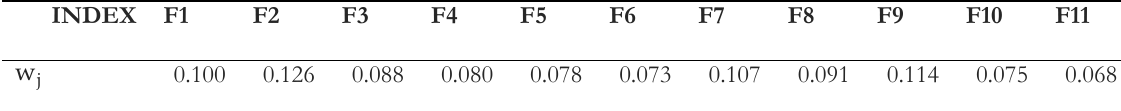
Table 13. Weight of each index after